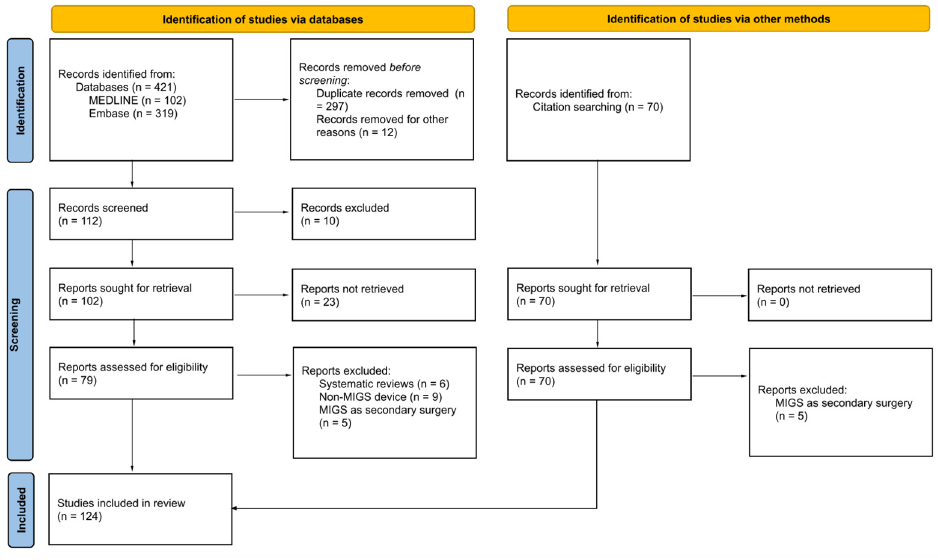
Figure 1. Method of the literature search.